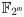
Implementation hierarchy of the ECC operations over F2m.